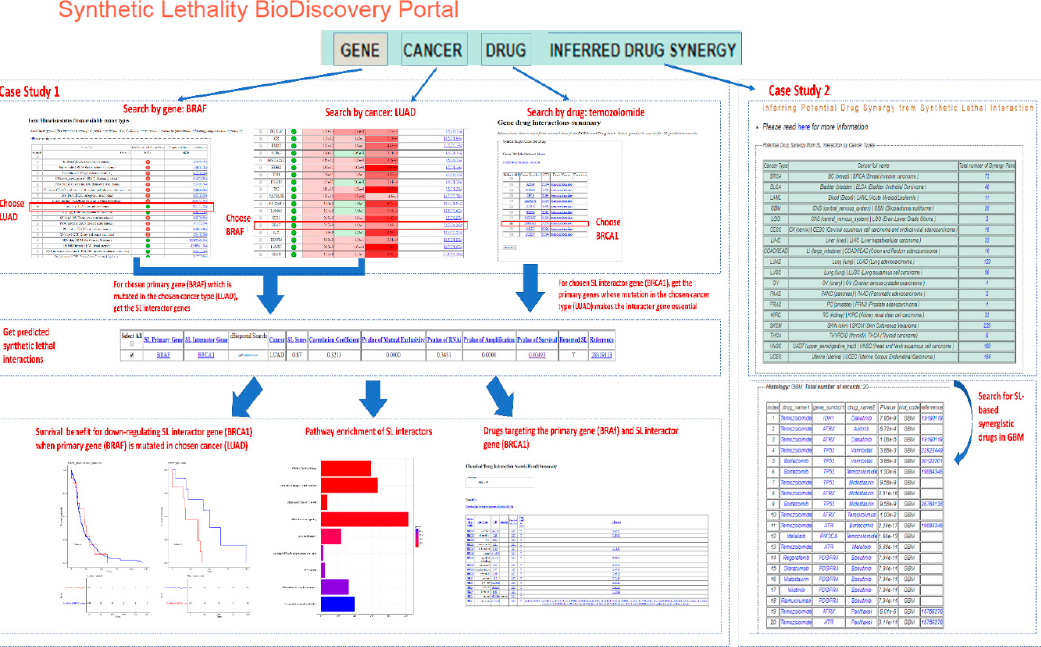
Figure 3. The utility of SL-BioDP is shown with a case study on BRAF in cancer lung adenocarcinoma (LUAD). Using “GENE” search in SL-BioDP, the mutation and expression alteration profile of BRAF across 18 tumor histology types is shown. BRAF is commonly mutated in LUAD (4.26%). Otherwise,